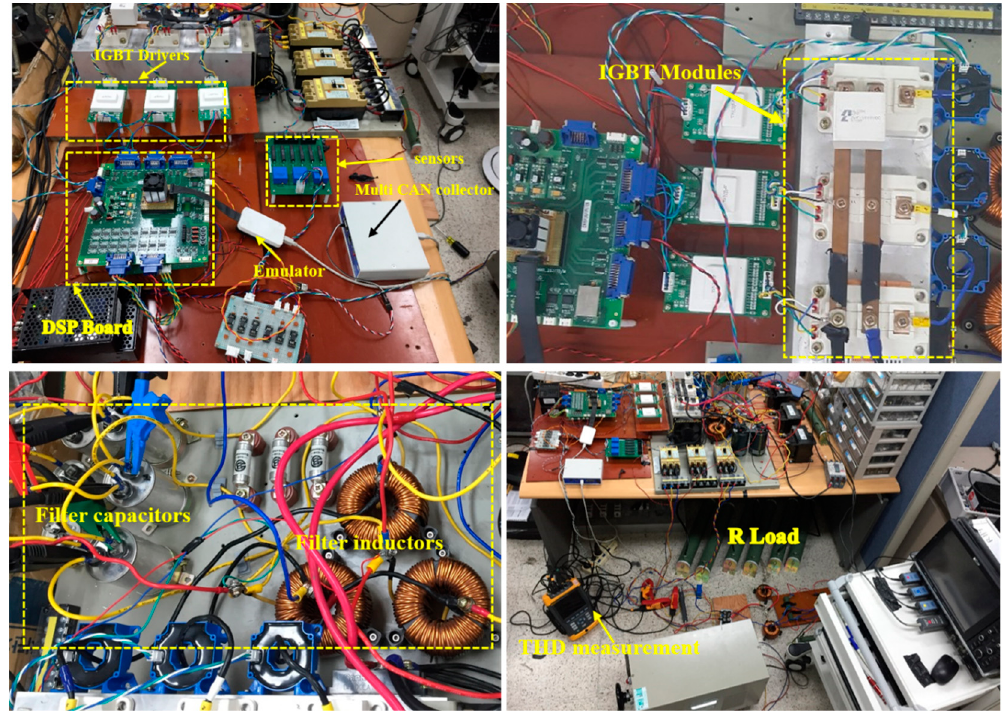
Figure 8. Experimental setup of the 5 kW three-phase inverter with output LC filter. Table 3. THD values for different (cid:2015) under the resistive load ( (cid:1844) = 10 (cid:2007) ).